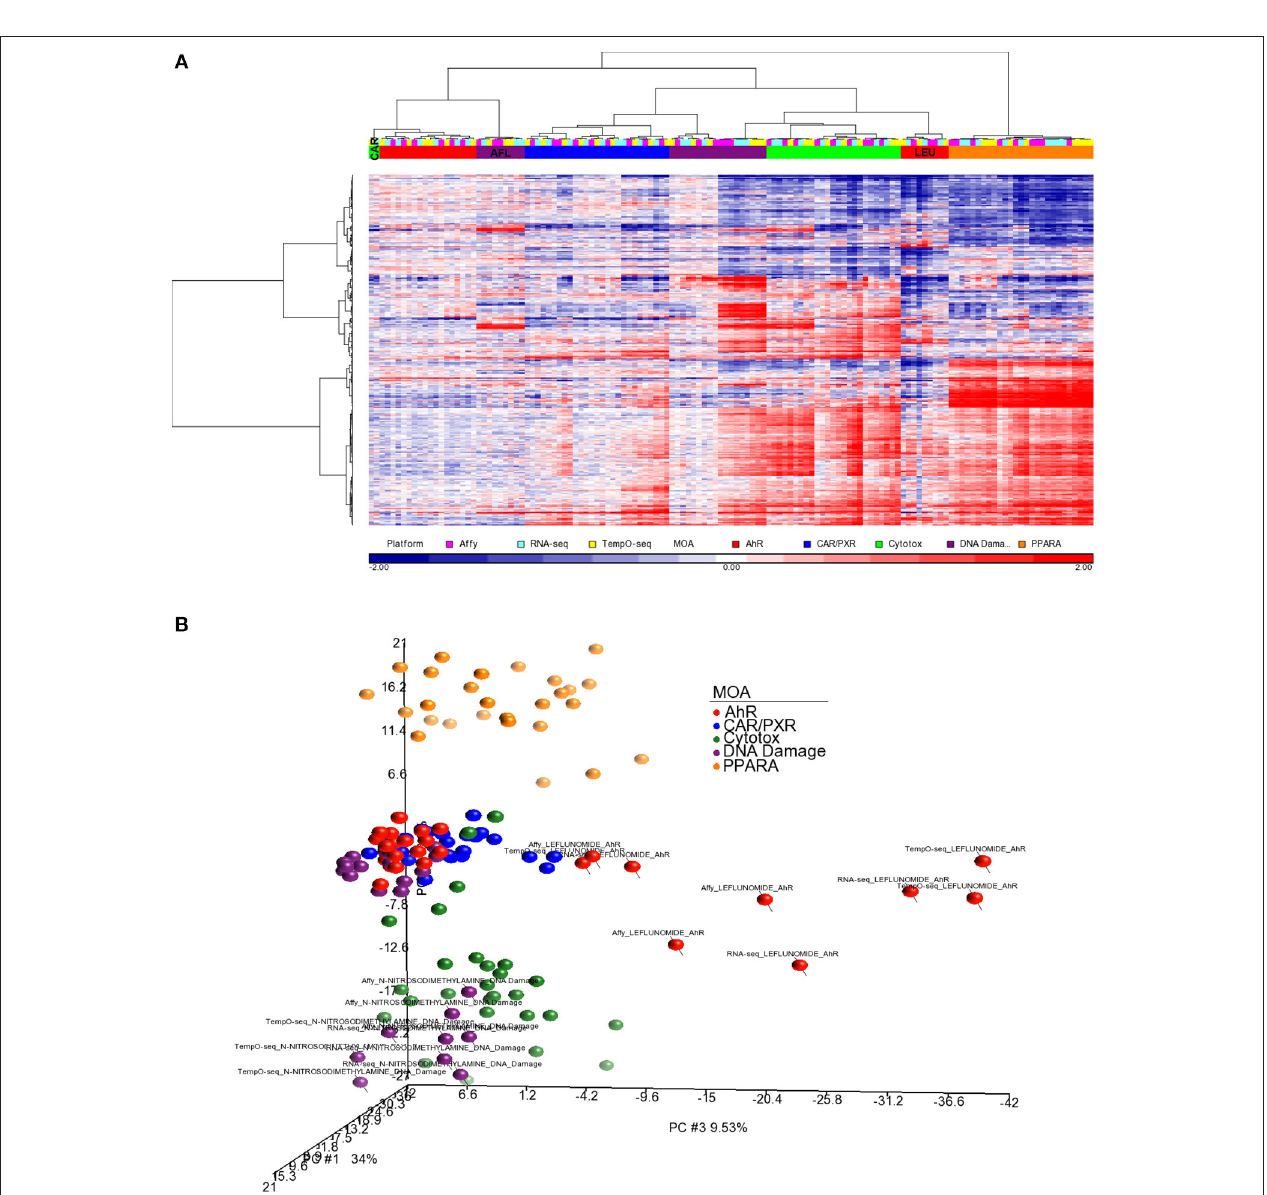
FIGURE 6 | Clustering of the data using a common gene set. (A) Hierarchical clustering performed using the log 2 ratio expression data (treated to matched control according to nutritional status) of the genes that vary by MOA at FDR < 0.01 and map to 731 UniGene cluster IDs that overlap between the three platforms. Genes that were mapped to the same UniGene cluster ID were averaged. The cosine correlation was used as the similarity metric and the Ward clustering criterion for merging clusters. Samples’ MOA colored as in the legend to Figure 4A . Platforms are represented by the following colors: pink, Affymetrix; light blue, RNA-Seq; yellow, TempO-Seq. (B) PCA of the data used in (A) . Principal component (PC) #1 = 34%, PC #2 = 16.6 %, and PC #3 = 9.53.